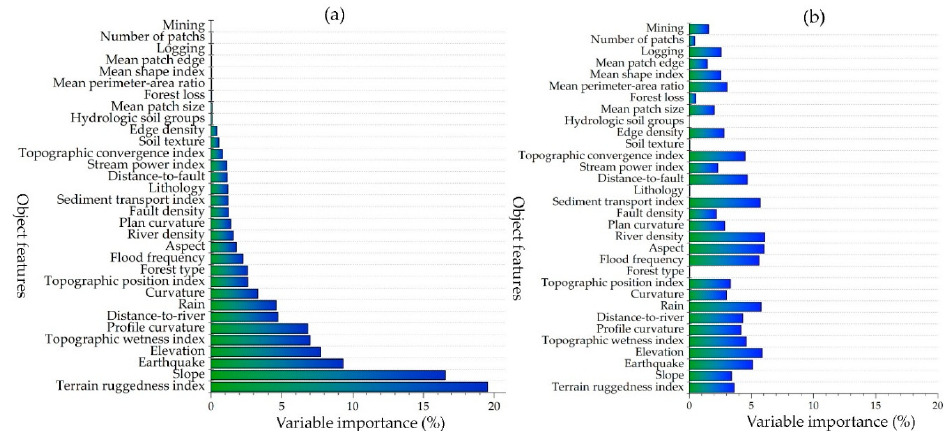
Figure 4. Comparison of the variable’s importance in controlling the susceptibility of protected forest ( a ) and non-protected forest ( b ) to landslides in NE Iran. While topographic, hydrologic, and natural triggering factors were dominant variables in the protected forest, the anthropogenic triggering factors recorded higher importance values than the natural triggering factors with a total value close to the importance of topographic and hydrologic variables in the non-protected forest in NE Iran.